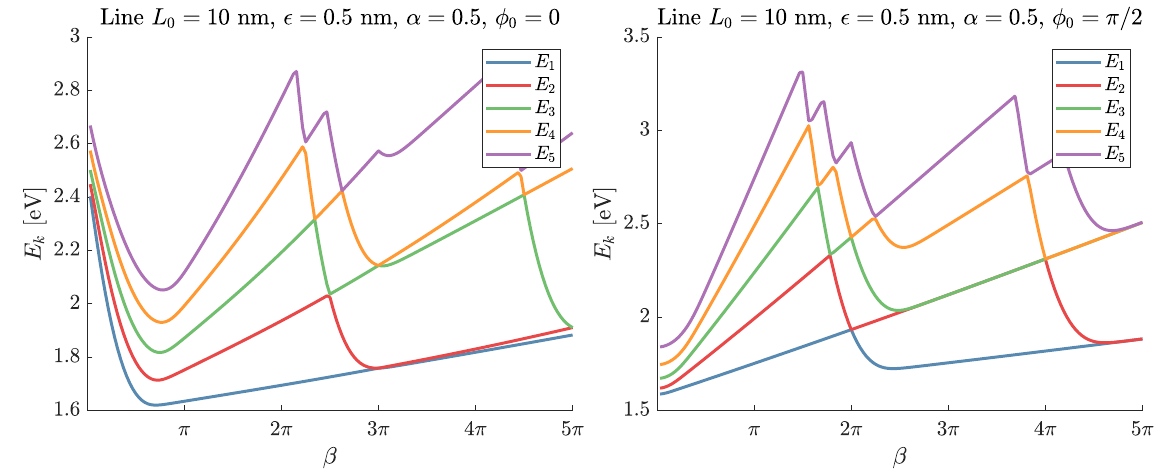
Figure 5. Energies for a tube around a straight line of length L 0 = 10nm, average width 1nm ( (cid:101) = 0.5nm), and with trigonometric variation of the width, h ( s ) = 1 + α